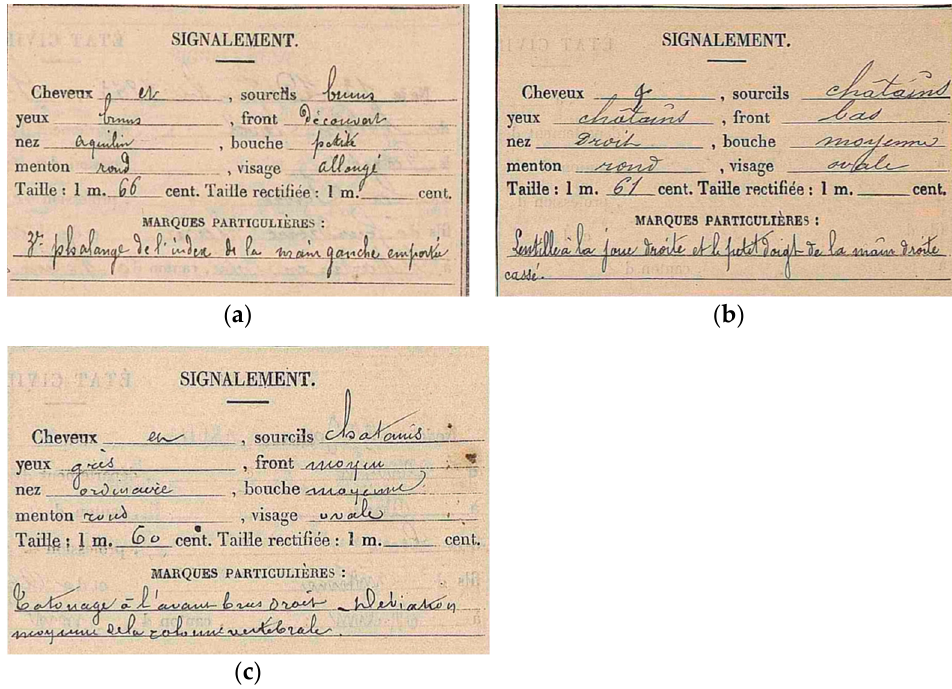
Figure 2. Military documents with mentions of particular conditions: ( a ) “3rd phalanx of the left hand amputated”; ( b ) “Broken right hand little finger”; ( c ) “Medium deviated spine”. © Depart- mental archives from Seine-et-Marne.